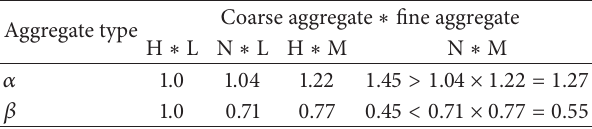
Table 10: Values of influencing factors in formula